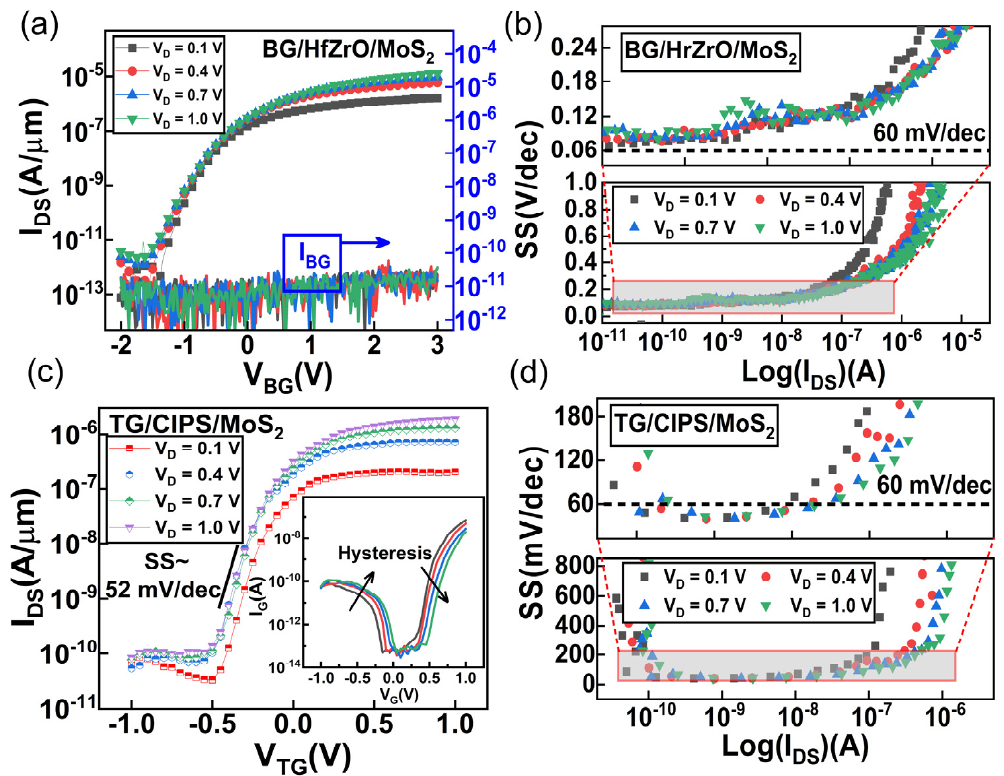
Figure 2. The electric characteristics of the CIPS/MoS 2 vdW ferroelectric transistor at room temperature. ( a , b ) The I-V characteristic and the SS-I DS characteristic of the back-gate configuration, respectively. ( c , d ) The I-V characteristic and the SS-I DS characteristic of the top-gate configuration, respectively.